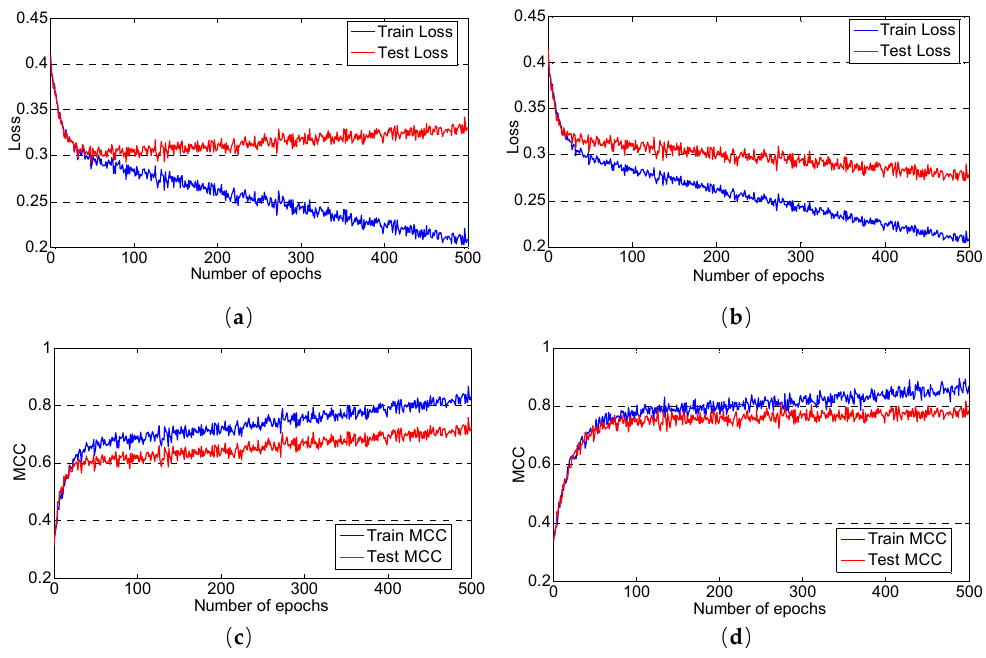
Figure 6. ( a ) and ( b ) is curve of loss , ( c ) and ( d ) is curve of MCC value.